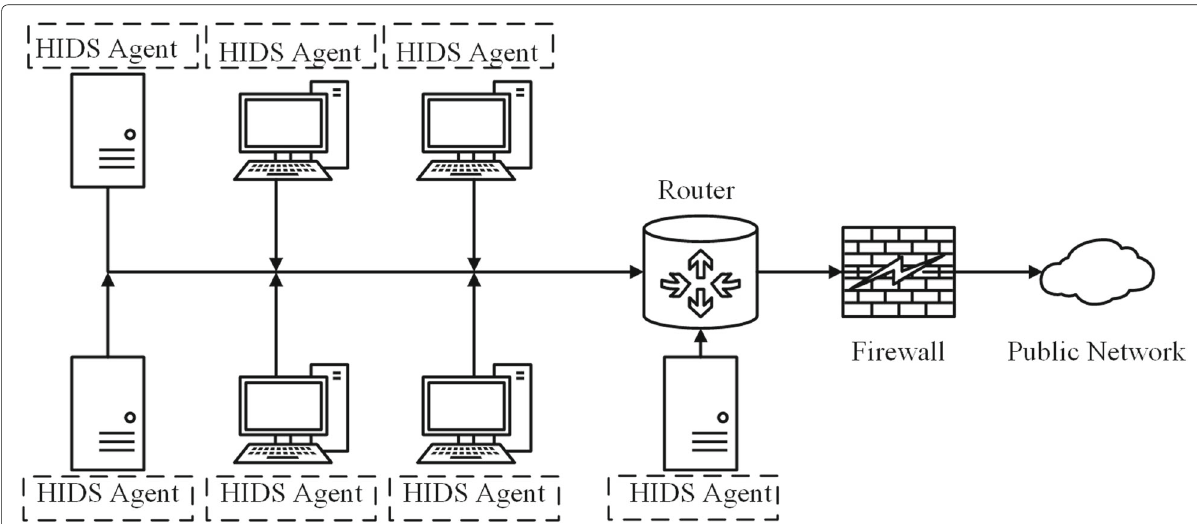
Fig. 6 Generic architecture of a host-based IDS (HIDS). The operational structure of a HIDS and its location in the